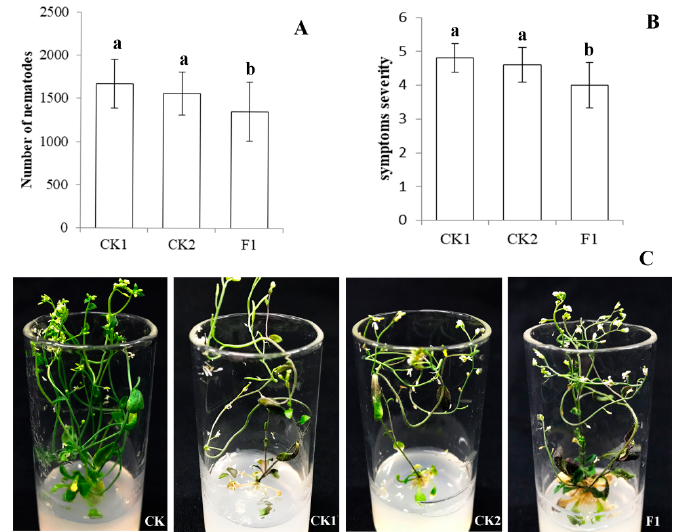
Figure 7. The induction of RNAi in Aphelenchoides ritzemabosi by soaking with Ar-far-1 dsRNA. ( A ) Expression of Ar-far-1 in A. ritzemabosi after different treatments. ( B ) Number of nematodes separated from carrot calluses inoculated with A. ritzemabosi under different treatments. G12-G72: A. ritzemabosi soaked in egfp dsRNA for 12–72 h. F12–F72: A. ritzemabosi soaked in Ar-far-1 dsRNA for 12–72 h. The data are the averages of 3 replicates + standard errors. Bars indicate the standard errors of the means ( n = 3), and different letters indicate significant differences ( p < 0.05) between treatments according to Duncan’s multiple range test. Int. J. Mol. Sci. 2019 , 20 , x FOR PEER REVIEW